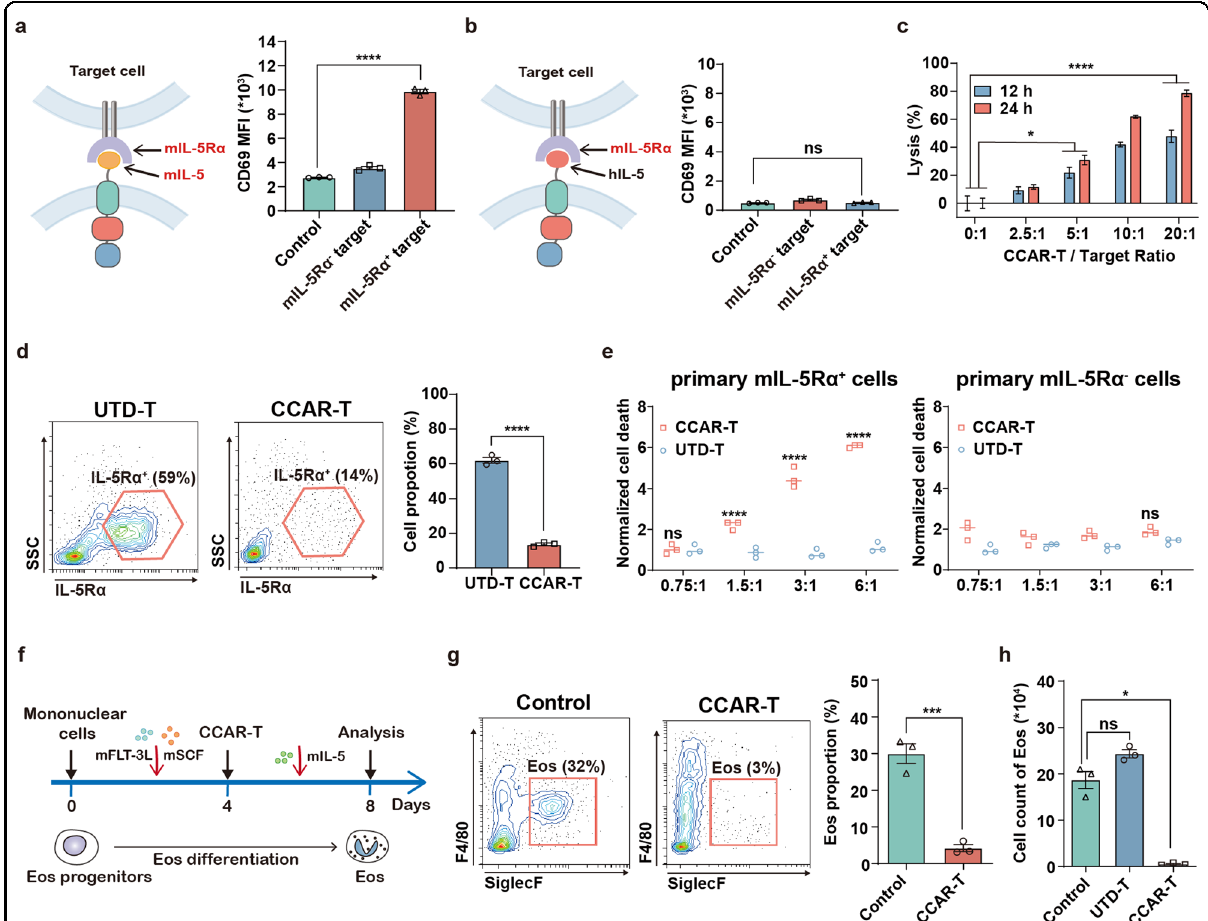
Fig. 3 IL-5-anchored CCAR-T cells show speci fi c cytotoxicity and inhibition of eosinophilic differentiation in vitro. a Jurkat cells were transduced with mIL-5-anchored CCAR comprising a mouse IL-5 linked to human CD28 costimulatory and CD3 ζ signaling domains (m.IL-5-h.28z). Flow cytometry analysis of CD69 expression on mIL-5-anchored CCAR-Jurkat cells after coculture with target cells (U2OS cells) for 24 h. One-way ANOVA, **** P < 0.0001. b Jurkat cells were transduced with hIL-5-CCAR comprising a human IL-5 linked to human CD28 costimulatory and CD3 ζ signaling domains (h.IL-5-h.28z). Flow cytometry analysis of CD69 expression on hIL-5-anchored CCAR-Jurkat cells after coculture with target cells for 24 h. Dunn ’ s Kruskal-Wallis test. c Primary T cells from BALB/c mice were transduced with mIL-5-CCAR comprising a mouse IL-5 linked to mouse CD28 costimulatory and CD3 ζ signaling domains (m.IL-5-m.28z). Cytotoxic activity of mIL-5-anchored CCAR-T cells against mIL-5R α + U2OS cells. Two-way ANOVA, **** P < 0.0001, * P < 0.05. d Flow cytometry analysis showing the proportion of primary mIL-5R α + cells derived from bone marrow